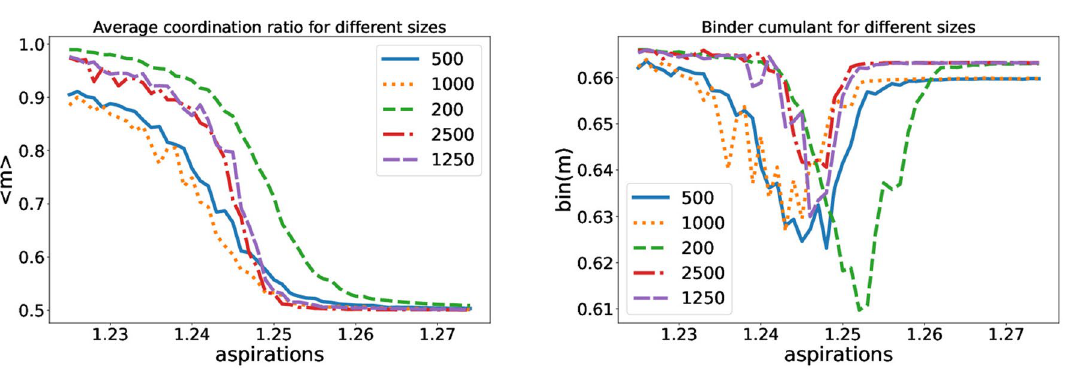
Figure 13. Average coordination ratio (left) and Binder cumulant (right) for several sizes in the 1 + δ/ 2